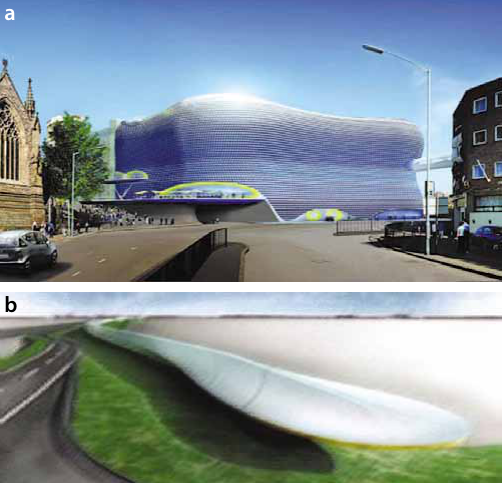
Fig. 12. Selfridges Supermarket (a), Birmingham, UK.